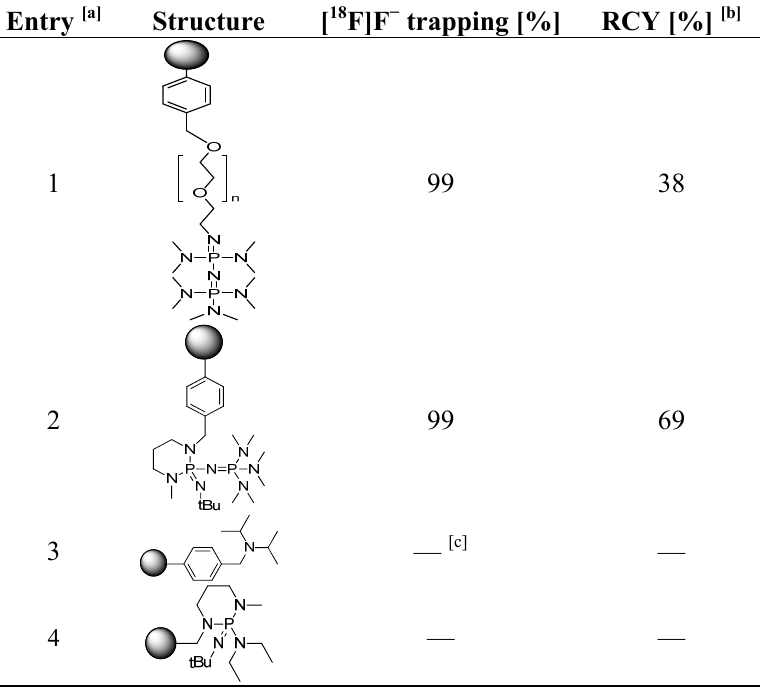
Table 5. Radiofluorination of Np(CH